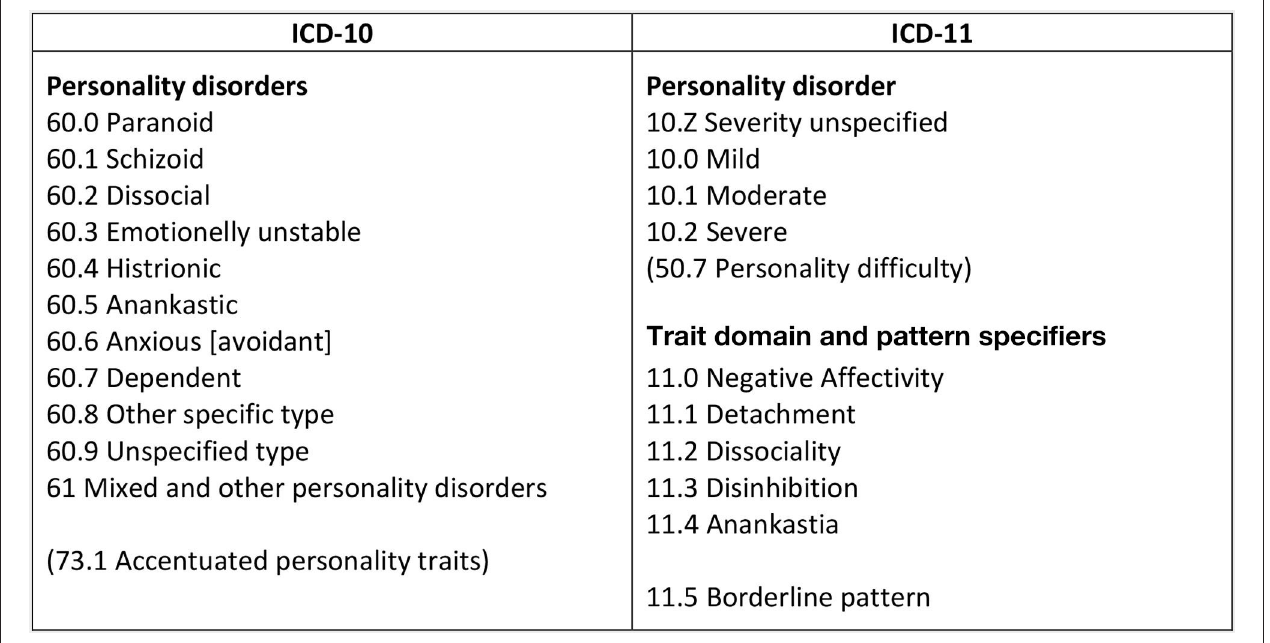
FIGURE 1 | Migration from ICD-10 to ICD-11 classification of personality